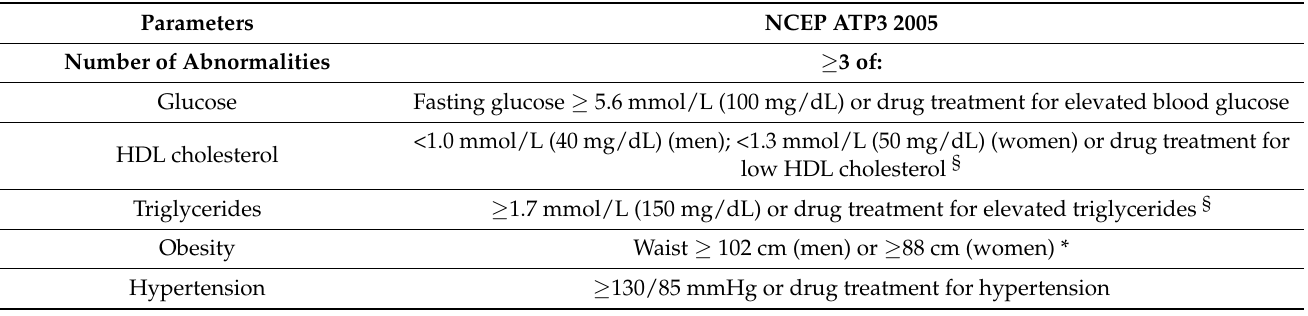
Table 1. Table summarizing the most commonly agreed-upon diagnostic criteria of metabolic syn- drome according to the NCEP ATP3 2005